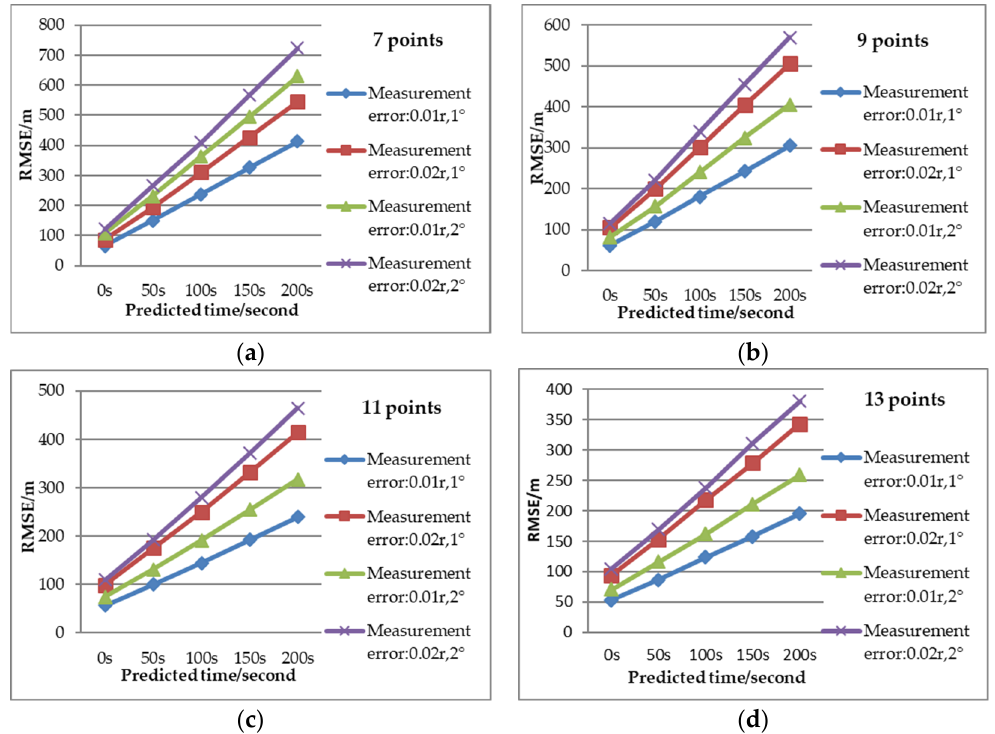
P = P ). e = P e 1 ). Figure 14. RMSE of predicted position versus different prediction time (Scenario 1, e 1 e